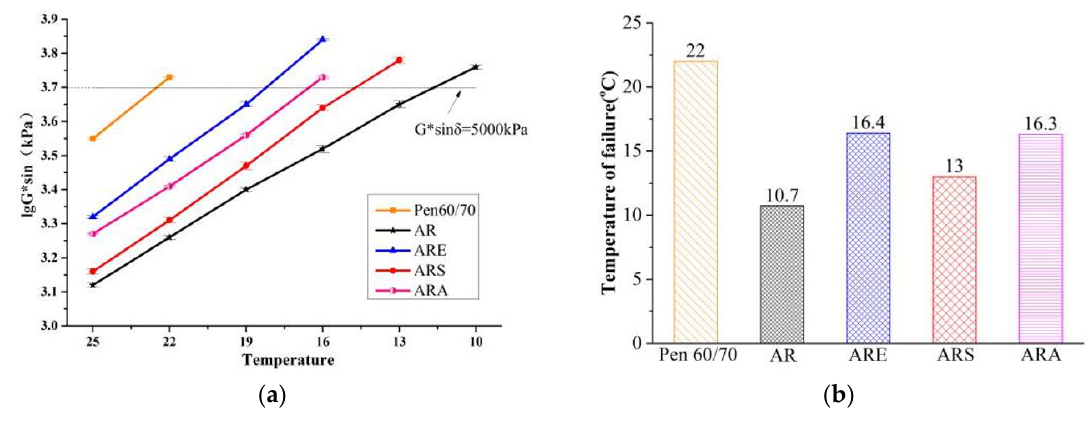
Figure 3. Superpave fatigue factor test results: ( a ) G*sinδ values; ( b ) failure temperatures.